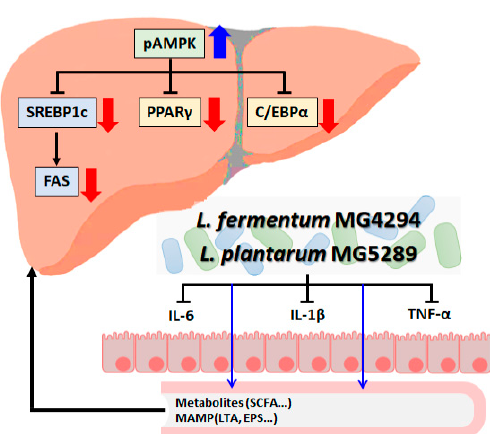
Figure 9. Effects of L. fermentum MG4294 and L. plantarum MG5289 on NAFLD by modulating of gut–liver axis. Thick blue arrows, increased expression by MG4294 and MG5289; thick red arrows, decreased expression by MG4294 and MG5289; thin blue arrow, generating metabolites by MG4294 and MG5289.